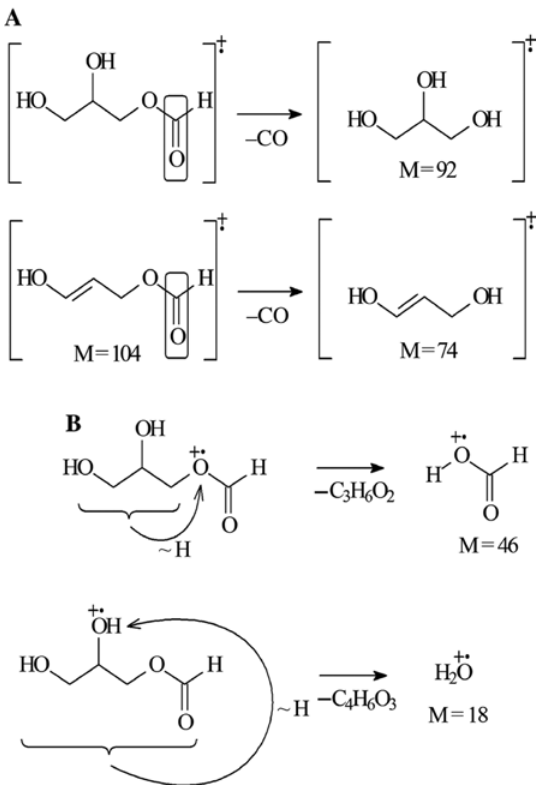
Figure 12: Two possible fragmentation paths of glycerin monofor- mate: (A) CO loss of the molecule ion or its dehydration product and (B) oxonium reaction that gives fragments of low